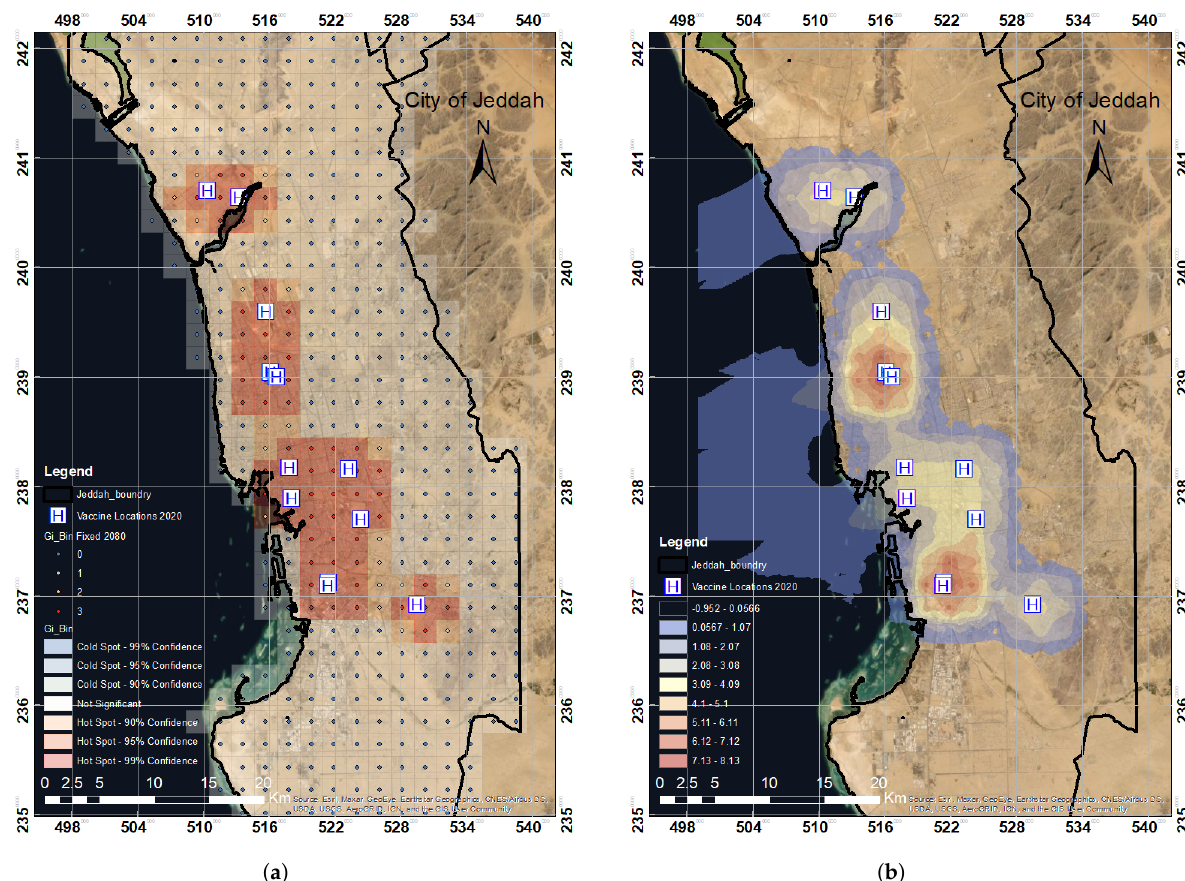
Figure 11. The regions of hotspots and coldspots in the study area ( a ) and the regions of significant and insignificant z -score values ( b ) based on the distribution of the COVID-19 vaccination centers established in 2020 in Jeddah. ( a ) Hotspot and coldspot map. ( b ) Spatial z -score